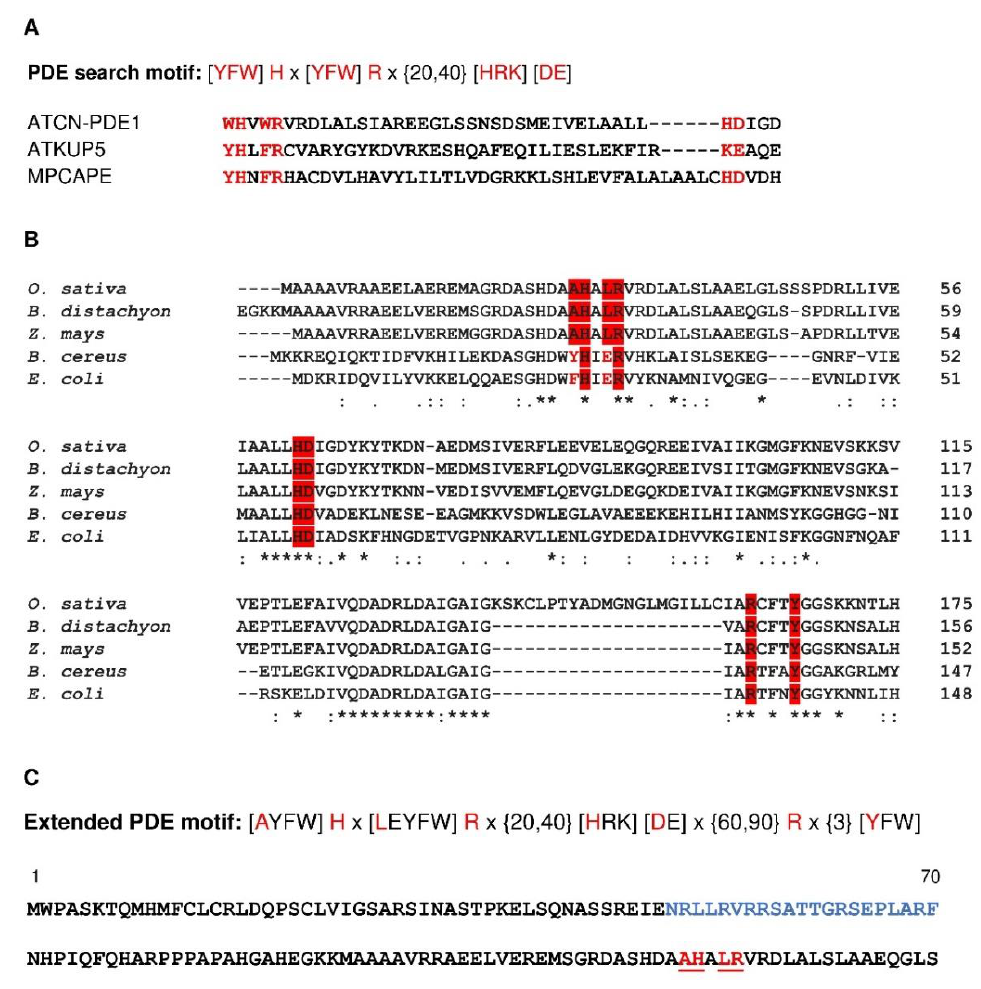
Figure 6. ( A ) Alignment of the known PDE centers of ATCN-PDE1 (At1g17330), ATKUP5 (At4g33530) and MPCAPE (Mapoly0068s0004). An * (asterisk) indicates positions that have a single, fully conserved residue. A: (colon) indicates conservation between groups of strongly similar properties. A. (period) indicates conservation between groups of weakly similar properties. ( B ) Alignment of the BDPDE1 orthologs in monocots O. sativa (NCBI: EEC67204.1) and Z. mays (NCBI: NP_001148226.1) and prokaryotes B. cereus (NCBI: CUB11224.1) and E. coli (NCBI: OJR83528.1). ( C ) Sequence of the extended PDE motif and amino acid sequence of the BDPDE1 protein (NCBI: XP_003574089.2). The key amino acids of the PDE motif are marked as red letters, and the calmodulin binding site is marked as blue letters.